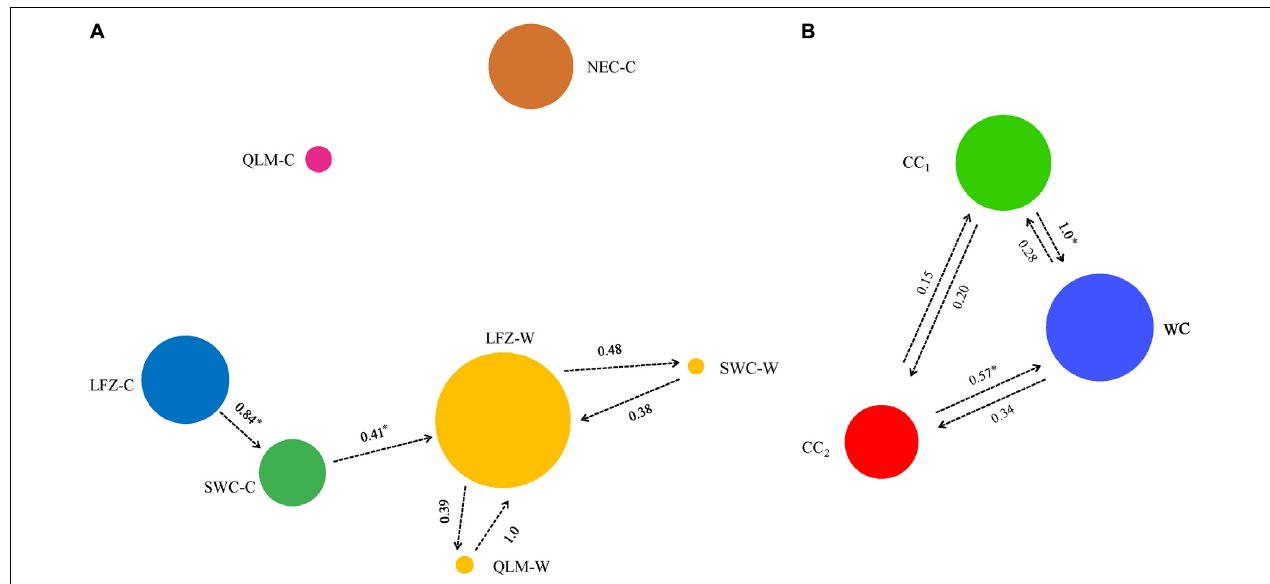
FIGURE 4 | Relative divMigrate networks for (A) Chinese cherry among different geographical regions and (B) three genetic clusters identified by STRUCTURE analysis using the divMigrate function in diveRsity . For (A,B) , the size of the circle illustrates the population size, and the colors are coincident with those in Figure 3B . The asymmetric values are shown alongside each arrow. In A, we only show the pairwise relationships with asymmetric values over 0.35. Both networks are generated following 1,000 bootstraps. Among all pairwise relationships, only those from LFZ-C to SWC-C, from SWC-C to LFZ-W, from CC 1 to WC and from CC 2 to WC are significant. ∗ P < 0.05. TABLE 2 | Q ST values for each trait and the mean F ST values between genetic clusters and among geographies. Phenotypic traits Between genetic clusters Among geographical